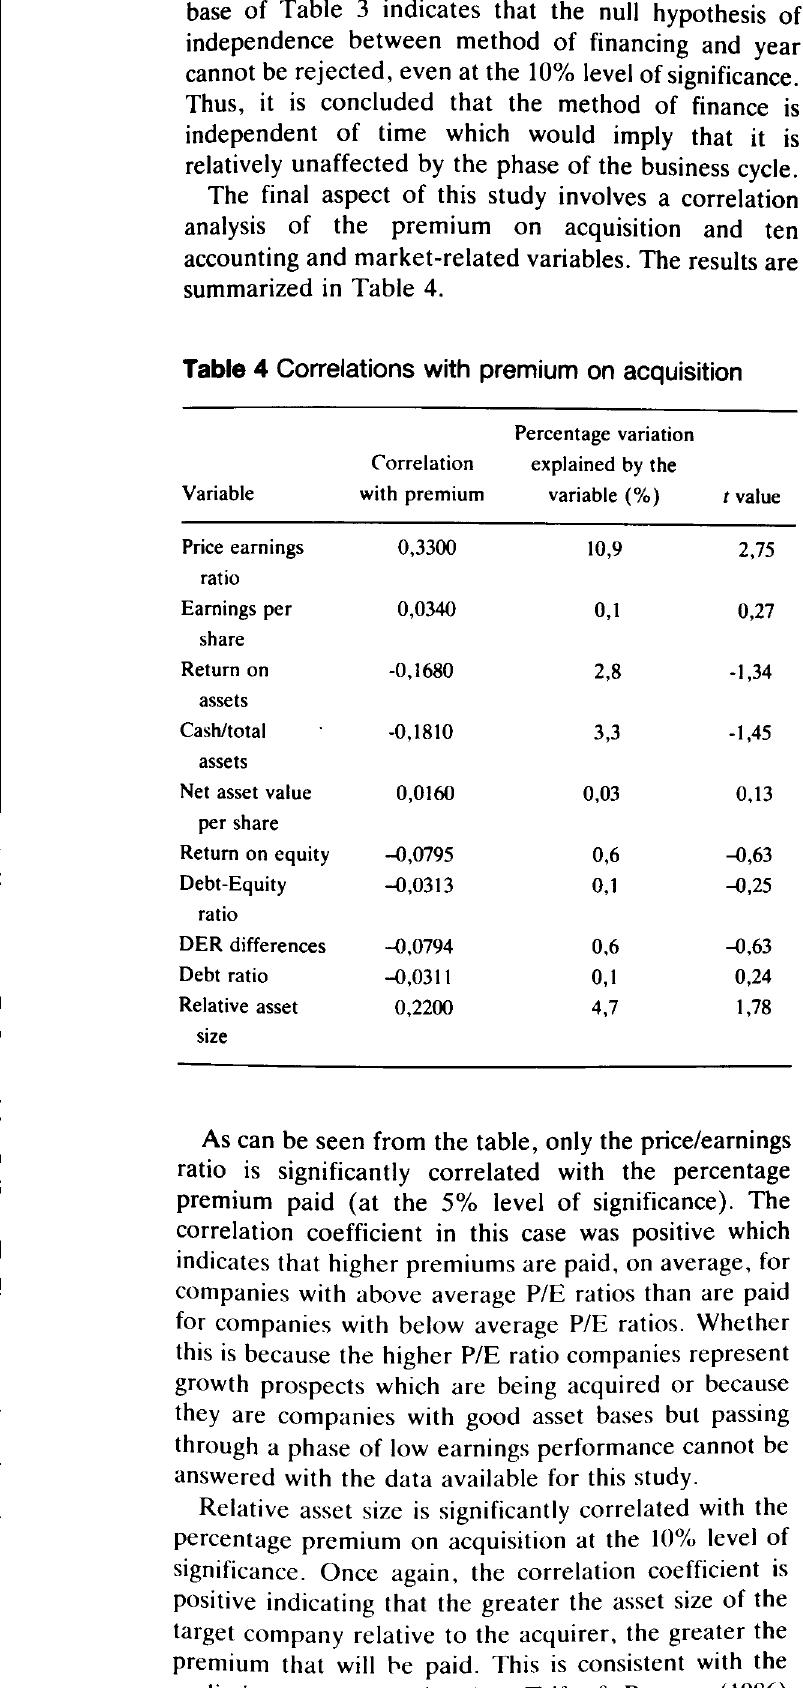
Table 4 Correlations with premium on